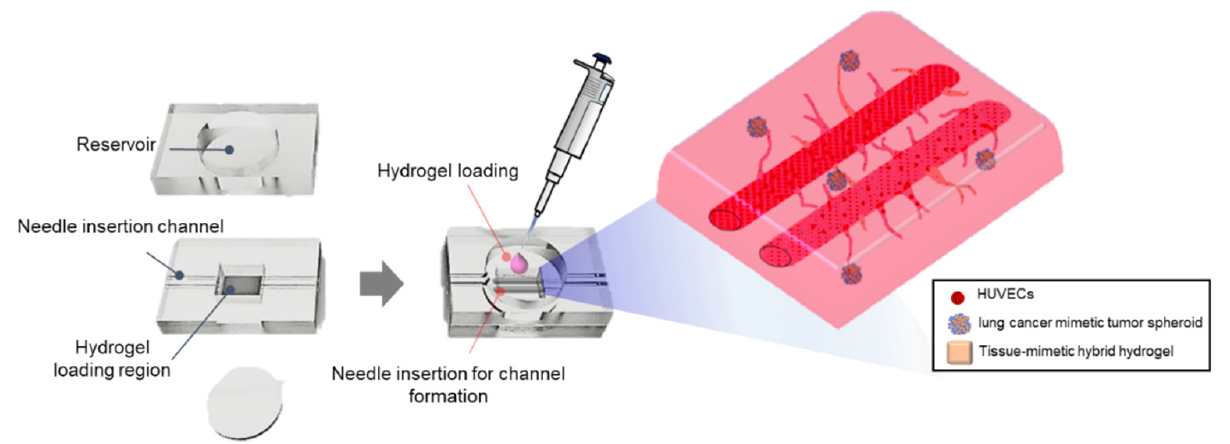
Figure 1. Schematic illustration of the VLCC. Lung cancer-derived tumor spheroids were encapsulated in the tissue-mimetic hybrid hydrogel to simulate the lung cancer tissue microenvironment. Two cylindrical macrochannels of 500 µ M diameter were endothelialized with HUVECs inside the matrix to mimic a perfusable large-sized vessel structure.